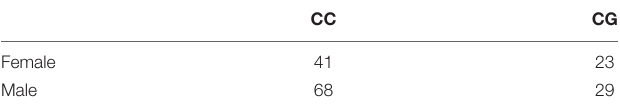
TABLE 1 | Frequency of maternal OPRM1 genotypes by offspring